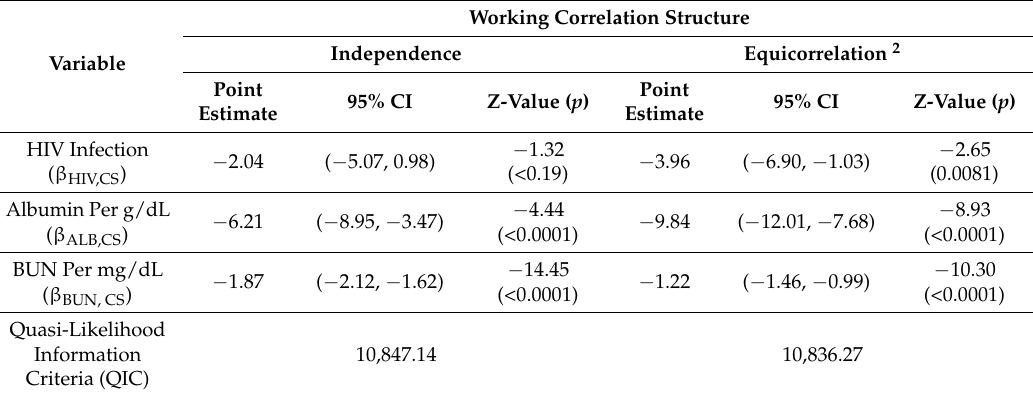
Table 1. Cross-sectional regression parameter estimates using GEE 1 for EGFR = HIV infection, serum albumin and BUN in the Bronx